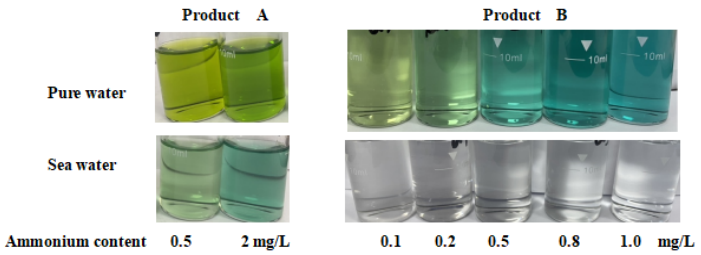
Figure 5. Comparison of the color changes of ammonium test kits from China (Product A: test kit suitable for low-hardness water from Zhejiang Lohand Environmental Technology Co. Ltd., Hangzhou, China; Product B: test kit from Guangdong Huankai Microbial Technology Co., Ltd., New York, NY, USA).